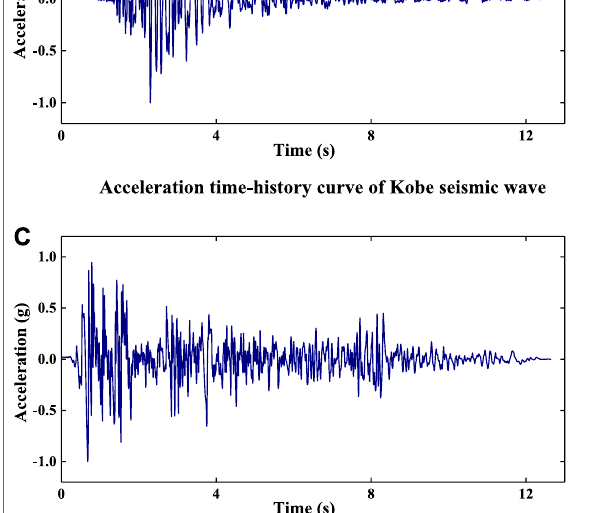
FIGURE 4 | Acceleration and displacement point arrangement in the test.